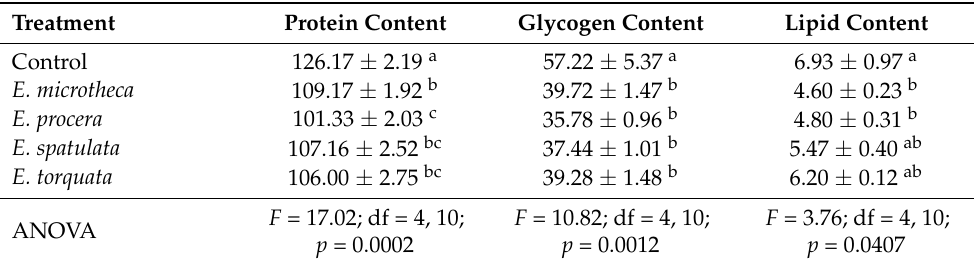
Table 4. The effects of low-lethal exposure to Eucalyptus essential oils (LC 30 concentration) on energy reserves ( µ g/adult) (Mean ± SE) of Rhyzopertha dominica adults.